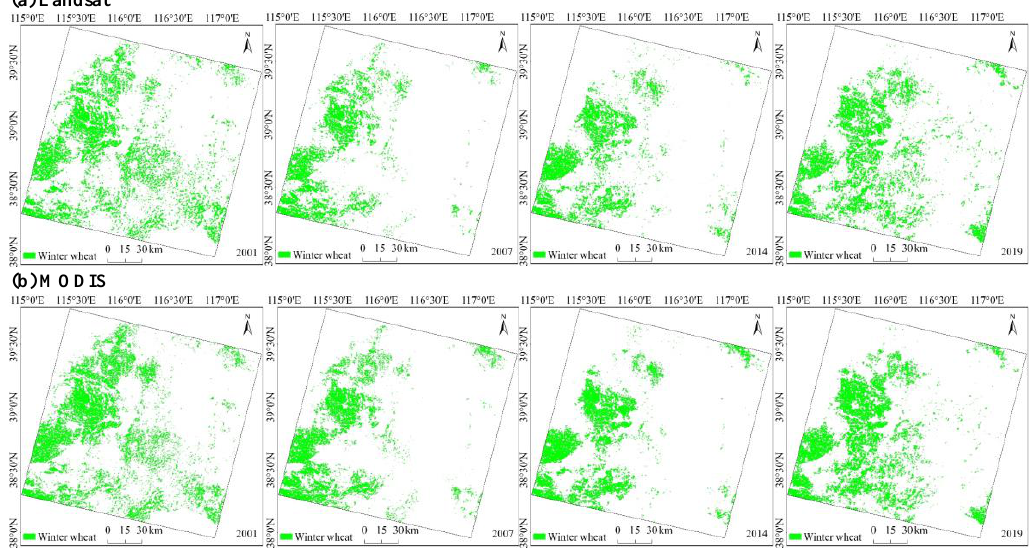
Figure 4. Maps of winter wheat in the 123033 tile area derived from ( a ) Landsat and ( b ) MODIS data in 2001, 2007, 2014 and 2019. Table 3. Accuracy assessment using Landsat-interpreted images from 2001 to 2019.